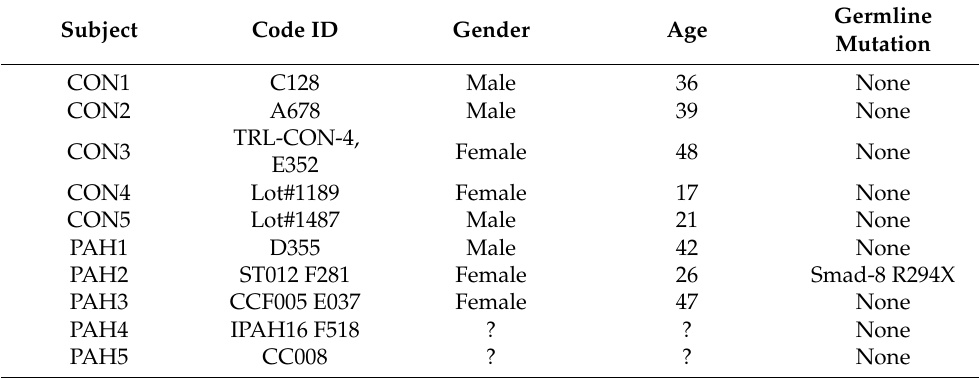
Table 1. List of HPASMC Donor